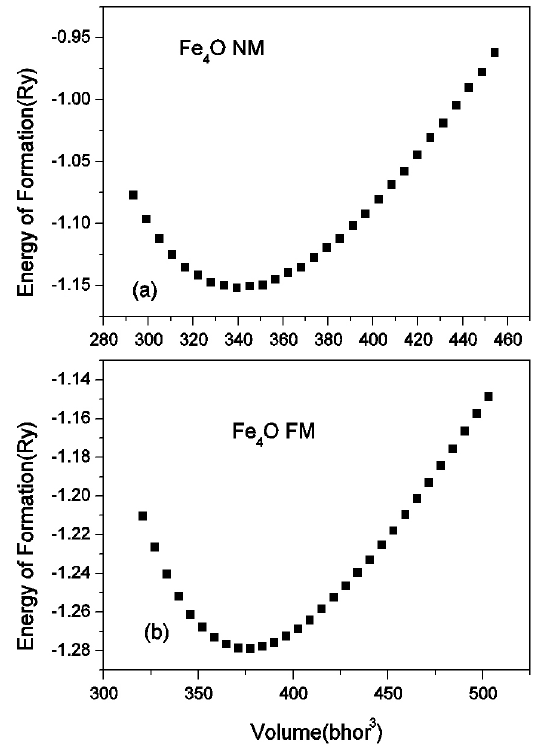
Figure 1. Cell unit model.